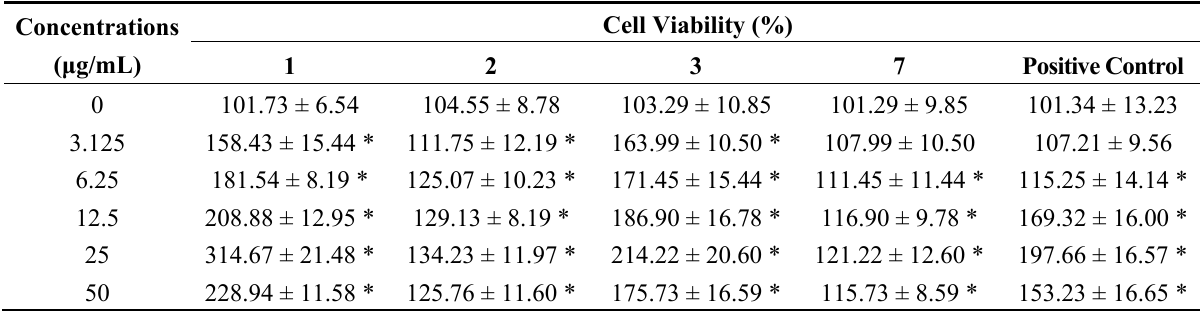
Table 1. Effects of the phenolics 1 – 3 , 7 on the proliferation of rat osteoblast cells after 48 h, as determined by MTT